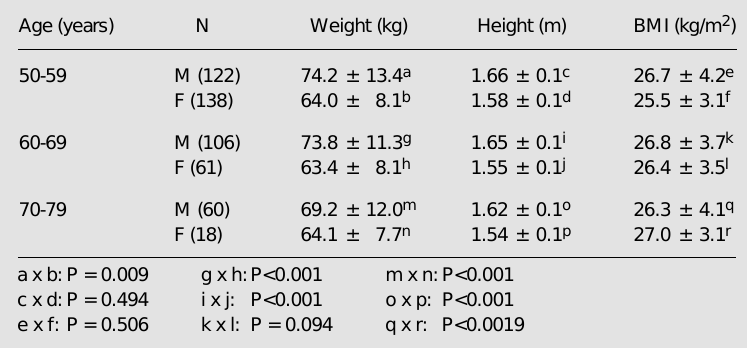
Table 4 - Comparison between Brazilian male (M) and female (F)* populations for weight, height and body mass index (BMI) stratified by decade. Data were analyzed statistically by the Student t -test. *Brazilian female population from Ref. 11.